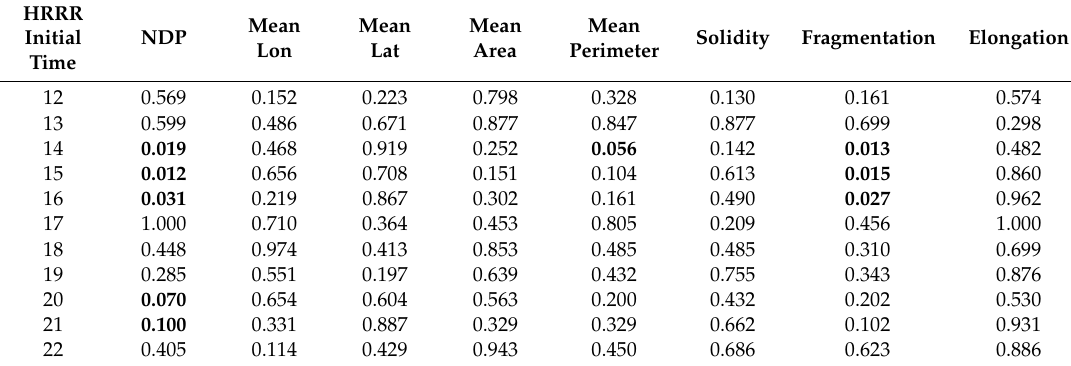
Table 5. Mann–Whitney U Statistics for 25.4 mm h − 1 (1 in h − 1 ) threshold for Jul 31, 2016 case. Bold font face indicates significance at 90% confidence